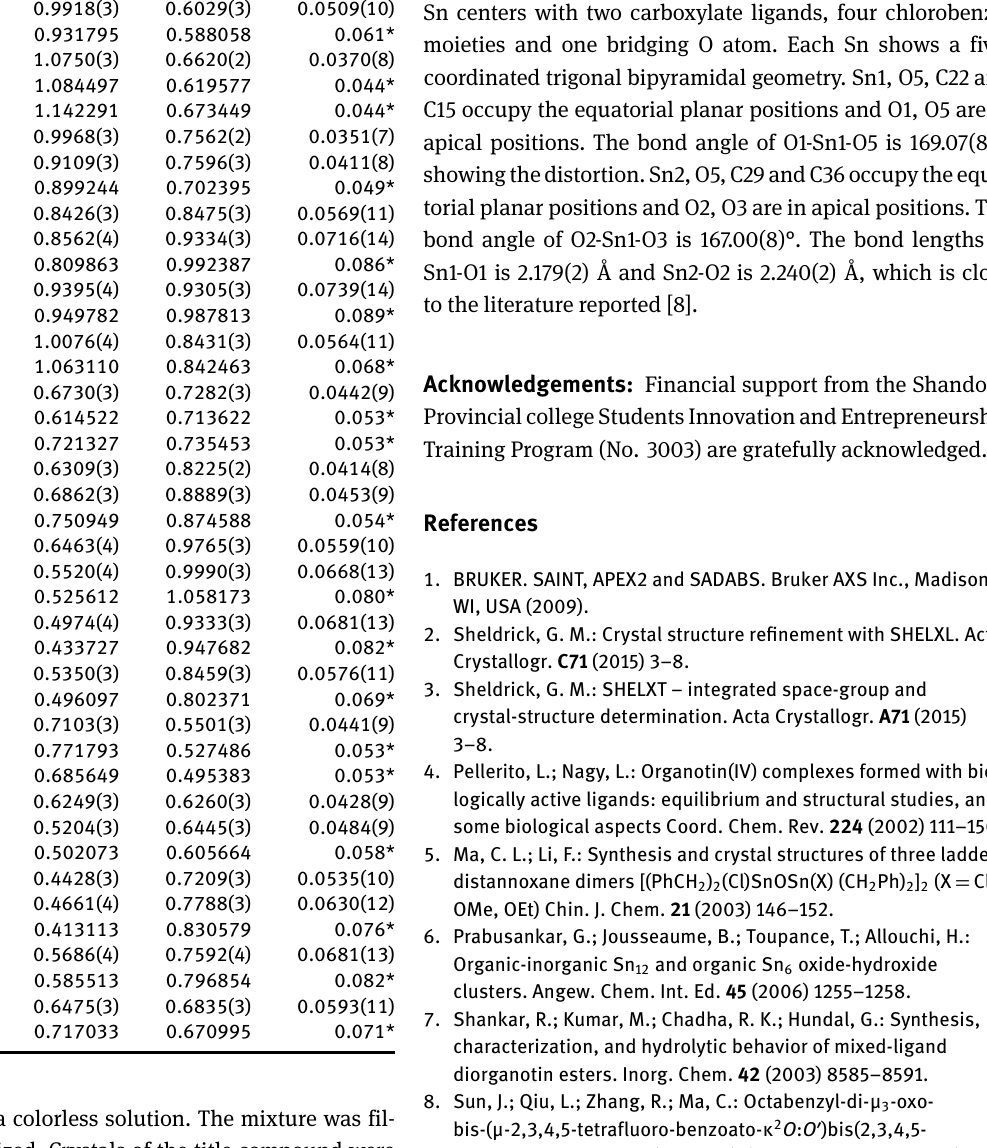
80 °C, resulting in a colorless solution. The mixture was fil- tered and recrystallized. Crystals of the title compound were obtained by slow evaporation within one